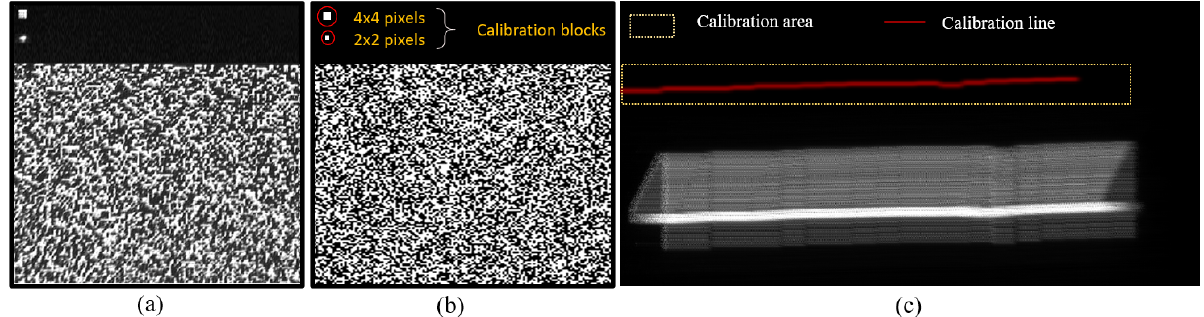
Figure 2. Comparison of the encoding patterns between the ( a ) observed pattern on the complementary metal oxide semiconductor (CMOS) ( b ) image of the designed pattern. ( c ) Movement profile of the rotating